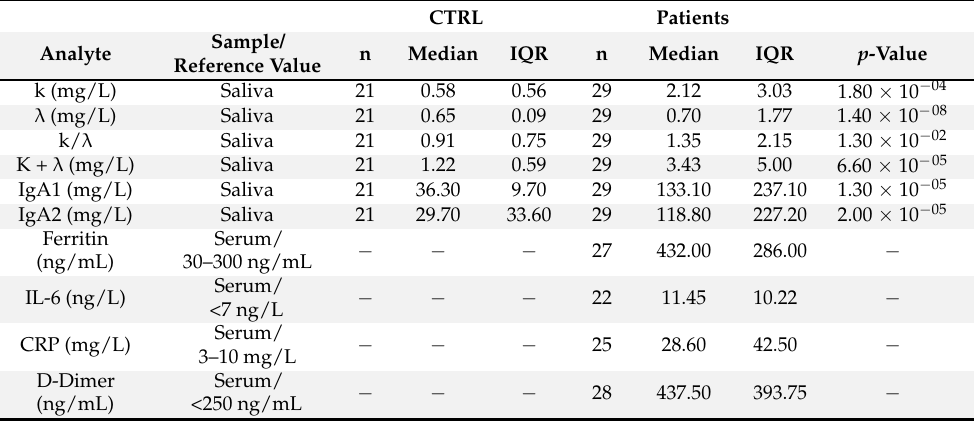
Table 2. Salivary and blood biomarkers in COVID-19 patients and healthy controls (CTRL). In column 2, we report reference values when available in